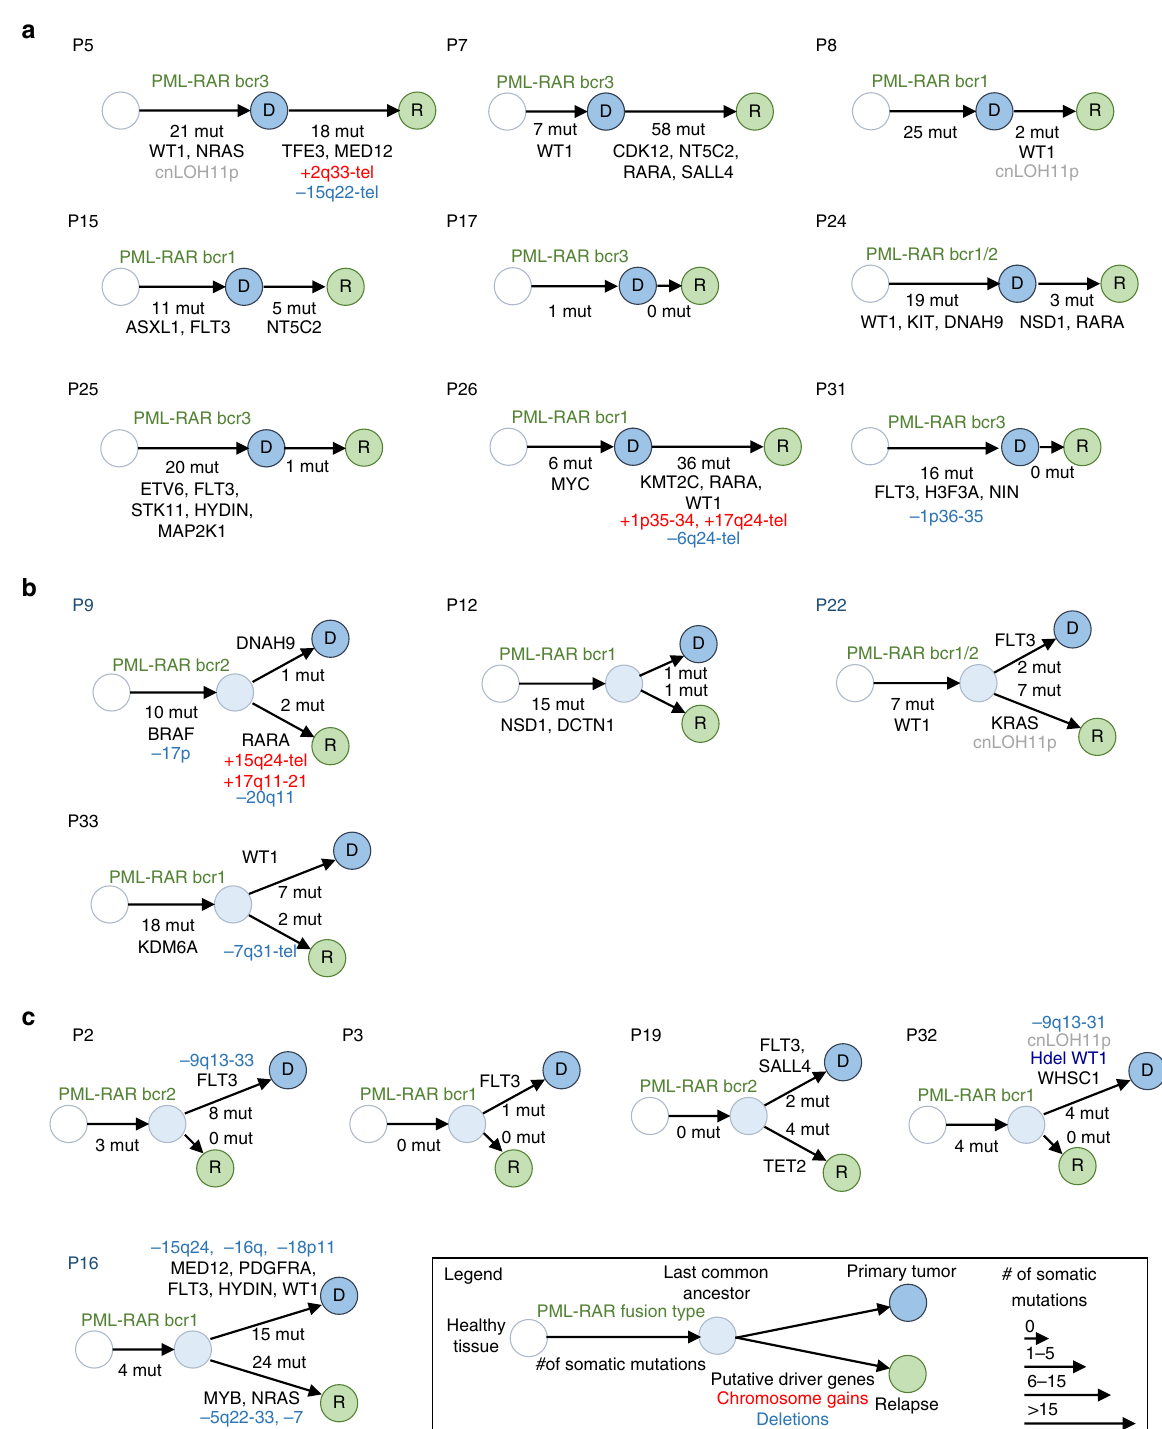
Fig. 2 Tumor progression trees reconstructed for 18 patients with matched primary tumor and relapse samples. For each patient, a diagram represents the predicted evolution linking the cell of origin (white circle), the PML/RARA-expressing common ancestor (light blue circle), the diagnostic sample (dark blue circle), and the relapse sample (green circle). The number of somatic protein-coding mutations occurring at each step is indicated below the arrows, together with the type of PML/RARA breakpoint, chromosomal gains (red), and deletions (blue), and mutations affecting known driver genes or new recurrent genes identi fi ed in this study. The size of arrows is proportional to the number of somatic mutations occurring at diagnosis or relapses. Three major modes of evolution are identi fi ed. a Nine patients present a linear evolution where all events detected at diagnosis are also present at relapse, with (P5, P7, P8, P15, P24, P25, P26) or without (P17, P31) new acquired alterations. b Four patients display branched evolution with many alterations shared by the primary and relapse samples but also speci fi c to one or the other, suggesting that the relapse evolved from a sub-clone of the primary tumor. c Five patients displayed no or very few alterations apart from the PML - RARA fusion in the relapse samples, suggesting that they emerged from pre-leukemic PML/RARA -expressing